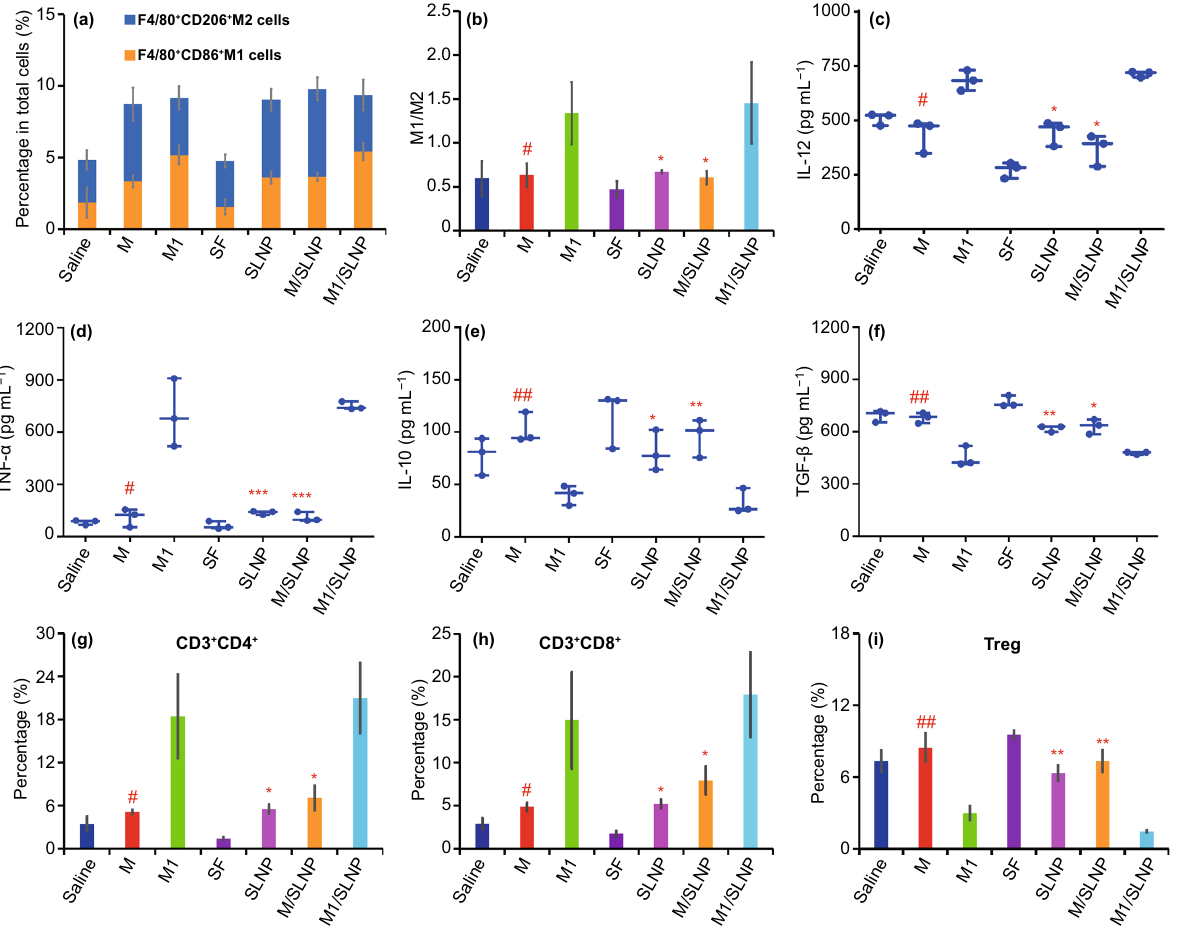
Fig. 5 M1/SLNP relieved the immunosuppressive tumor microenvironments. The analysis of macrophages, CD3 + CD4 + T cells, CD3 + CD8 + T cells and Treg in tumor tissues after the in vivo antitumor efficacy study. Quantitative analysis of M1-type macrophages and M2-type mac- rophages in tumor tissues by FCM: a percentage of M1-type macrophages (F4/80 + CD86 + M1 cells, blue bar chart) in total cells in tumor tissues and the percentage of M2-type macrophages (F4/80 + CD206 + M2 cells, yellow bar chart) in total cells in tumor tissues after treatment with for- mulations (NS, M, M1, free SF, SLNP, M/SLNP, and M1/SLNP); b ratio of M1/M2. The levels of cytokines in blood serum: c IL-12; d TNF-α; e IL-10; f TGF-β. g‑i Percentage of CD3 + CD4 + T cells (g) , CD3 + CD8 + T cells (h), and Treg (i) . ## p < 0.01, # p < 0.05, compared with M1; *** p < 0.001, ** p < 0.01, * p < 0.05, compared with M1/SLNP, n =